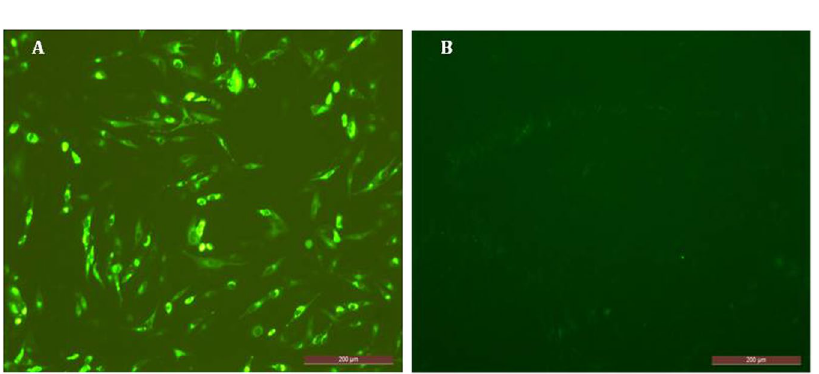
Figure 2. Indirect immunofluorescence assay (IFA). EMCV-C15-infected BHK21 cells and uninfected control cells were examined by IFA using EMCV-specific monoclonal antibodies (( A ), EMCV C15-infected BHK21 cells; ( B ), negative control BHK21 cells; scale bar, 200 μ